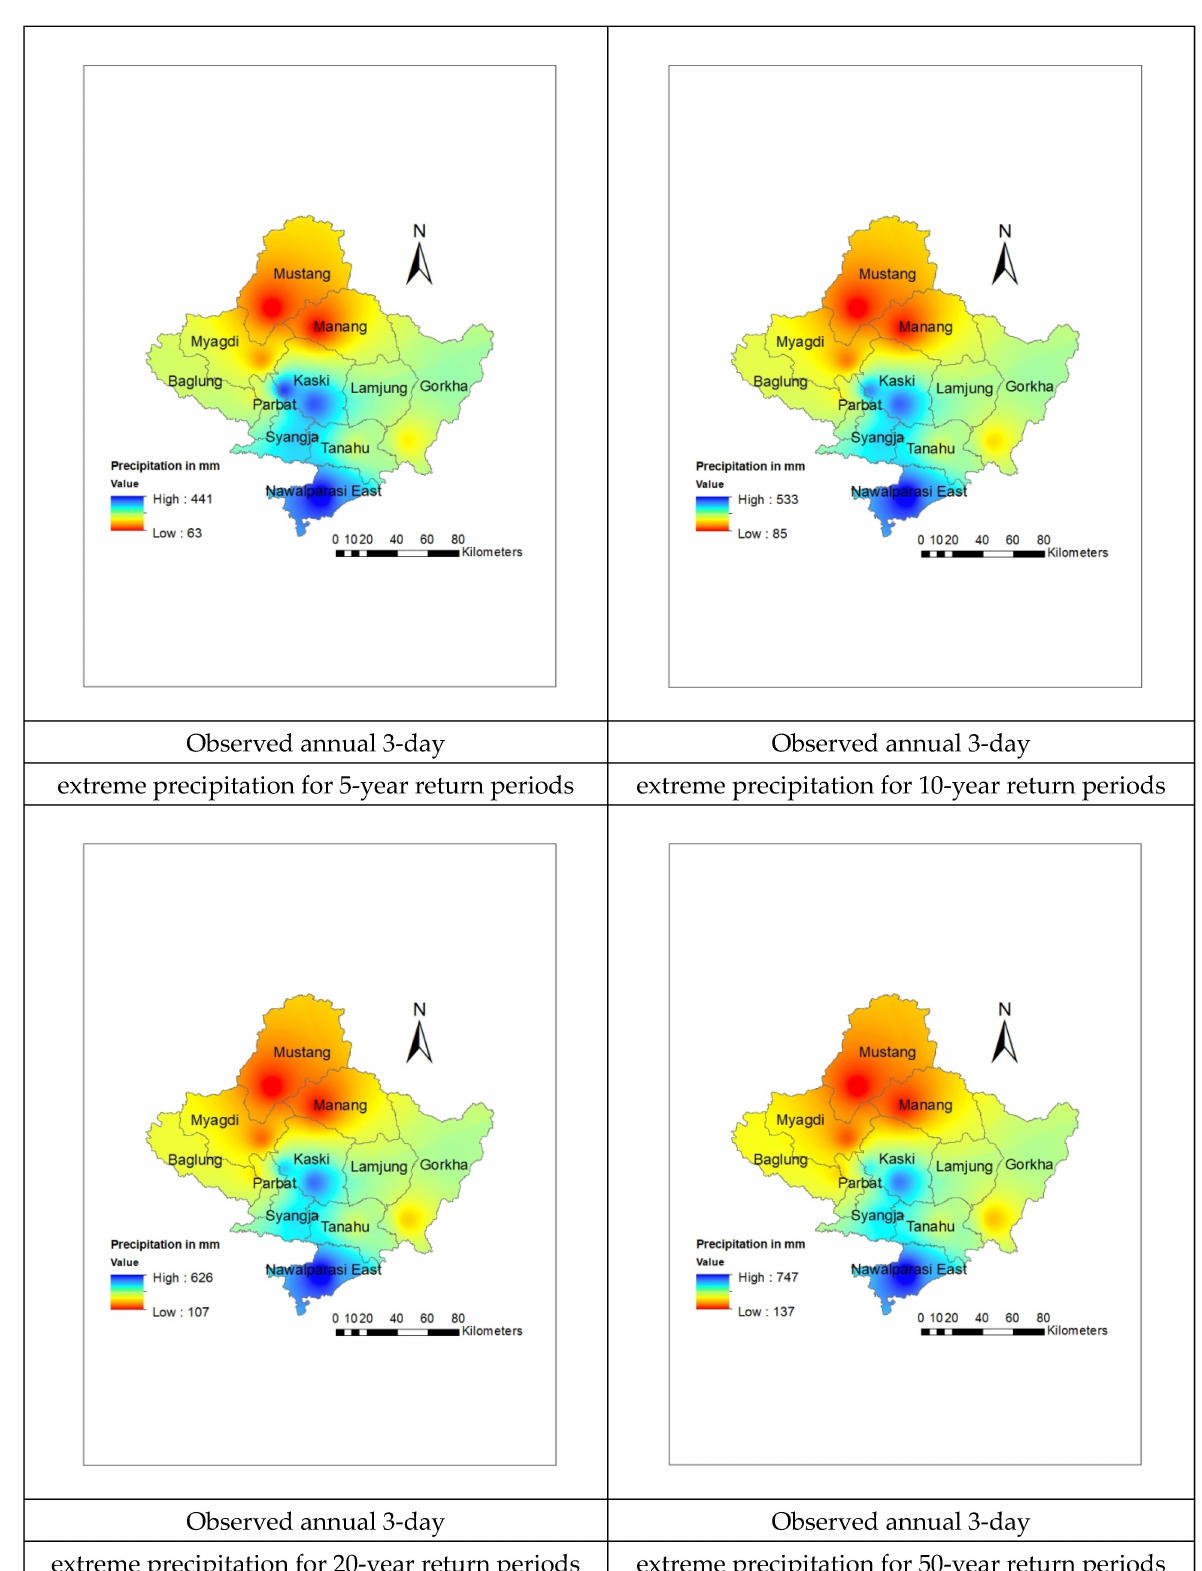
Figure A16. Cont